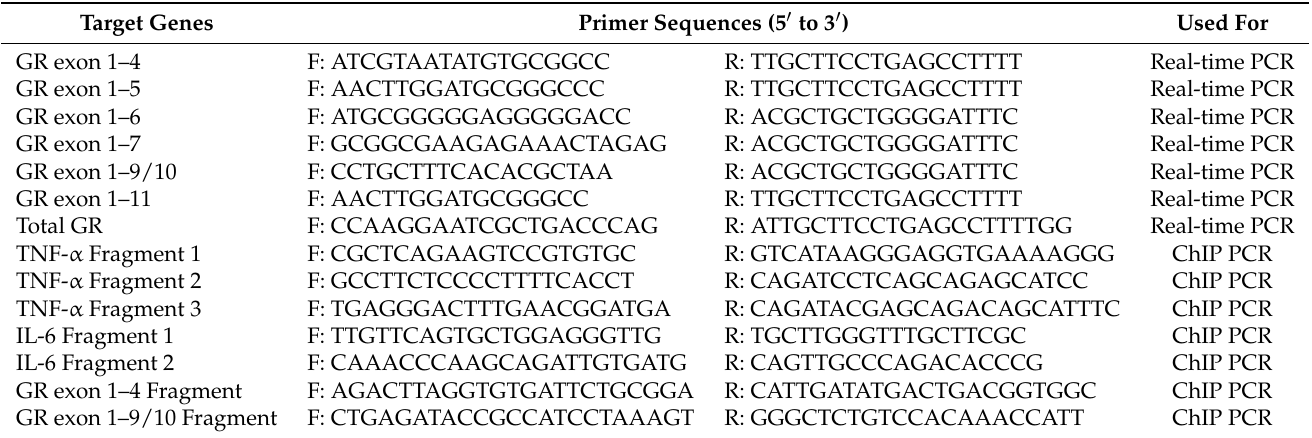
Table 1. Nucleotide sequences of